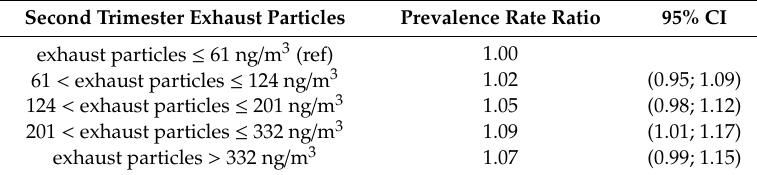
Table A3. Non-linear associations between second trimester exhaust particles and small for gestational age.